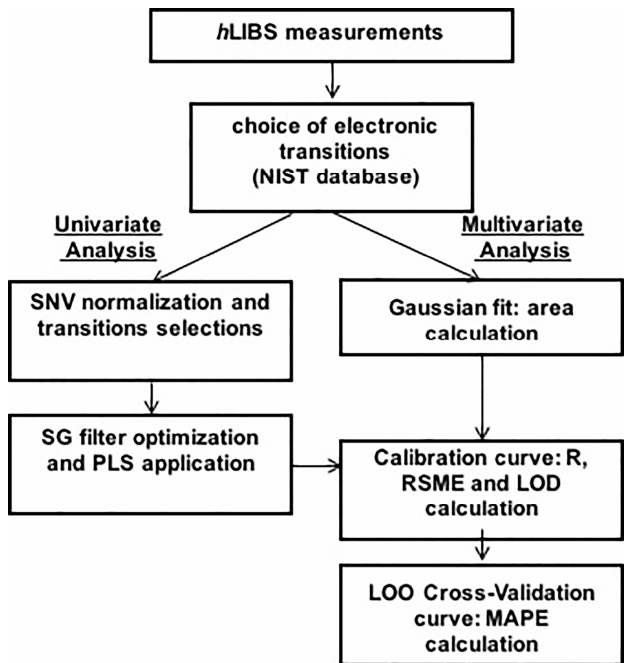
Figure 2. Workflow of the analytical steps performed.